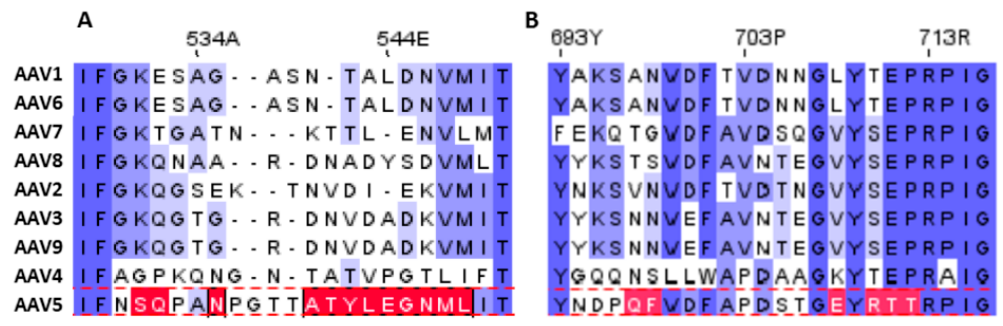
Figure 7. Alignment of variable regions VII ( A ) and IX ( B ) of various AAV serotypes with AAV5, done by first using Clustal Omega [44], then manually adjusted for consistency with structural superimposition. Residues that bind PKD1 are highlighted in red. This alignment shows little conservation of PKD1 binding residues from AAV5 with any other common serotype.